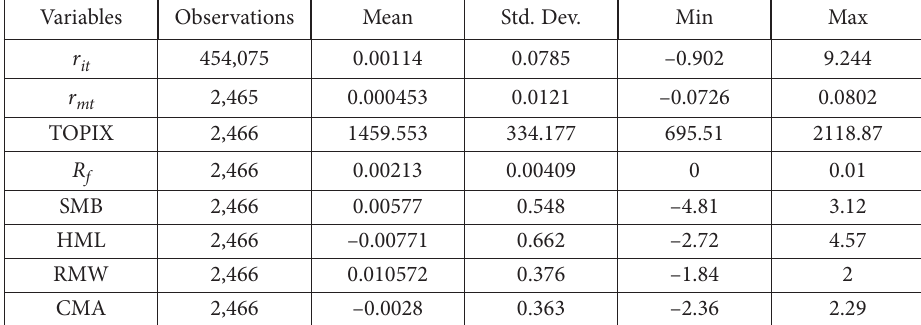
Table 2. Summary